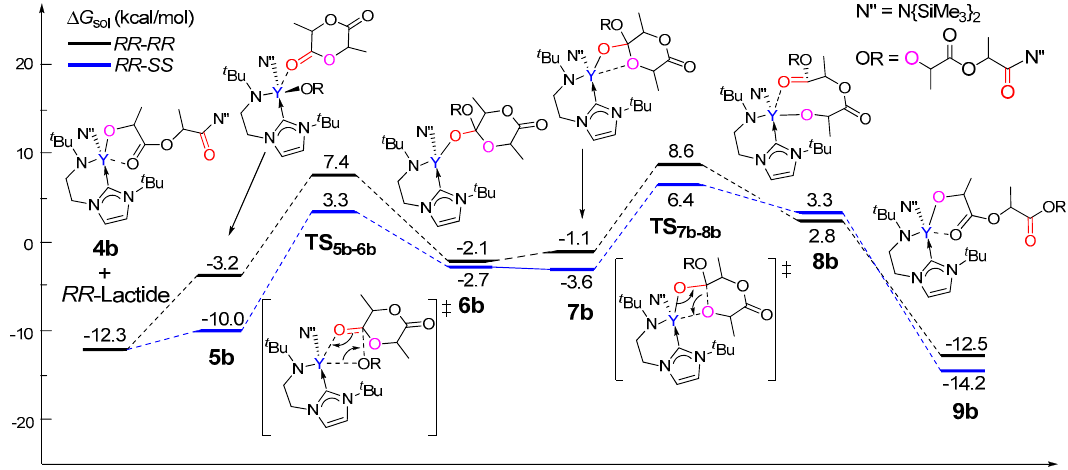
Figure 5. Calculated free energy profile for the ring-opening polymerization of the second rac -lactide monomer.